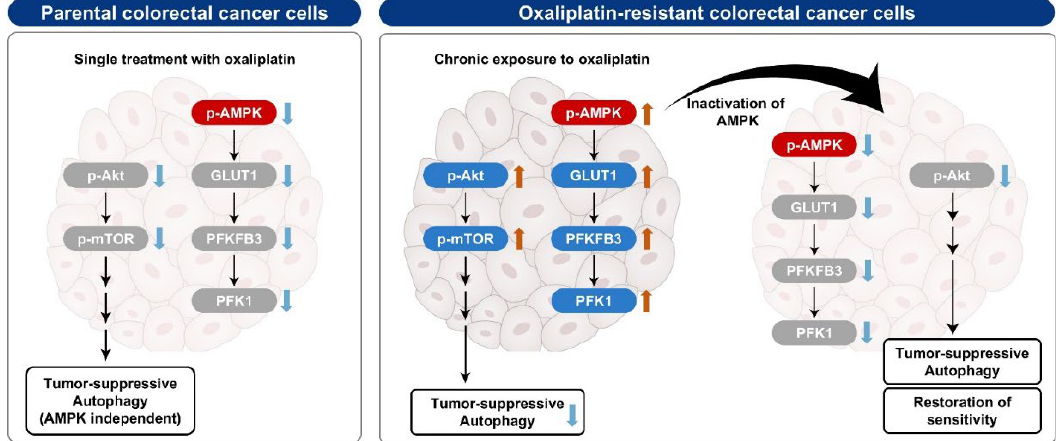
Figure 10. Summary of possible mechanism in parental (PT) and oxaliplatin-resistant (OR) colorectal cancer cells. p-, phospho-.